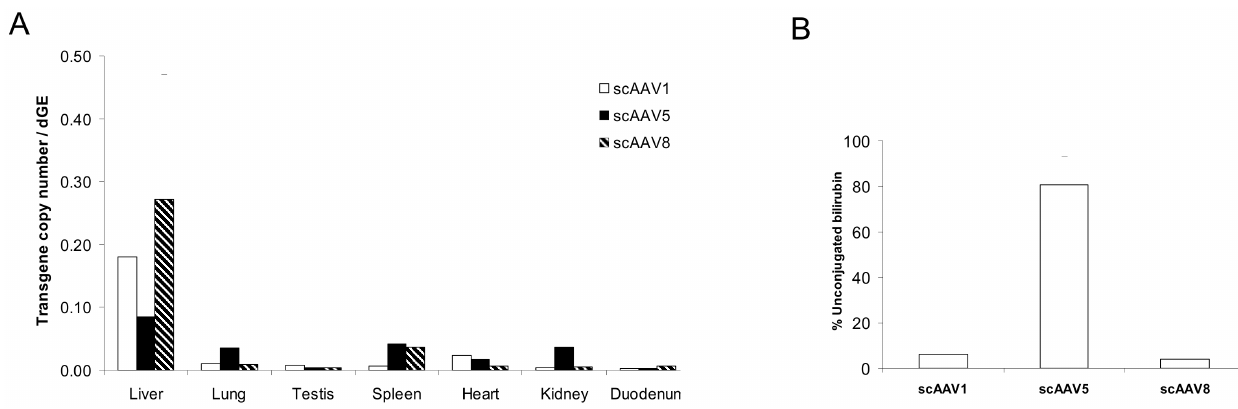
Figure 2. scAAV2/1, 5 and 8 vectors biodistribution and UGT1A1 mRNA expression levels in liver tissue. (A) UGT1A1 transgene copy number per diploid genome equivalent (dGE) in liver, lung, testis, spleen, heart, kidney and duodenum of male Gunn rats at 62 weeks after portal vein injection of scAAV1, 5 or 8 as calculated by the ratio of UGT1A1 copies and the rat b -actin gene copies in 100 ng of DNA as quantified by qPCR. (B) Relative UGT1A1 mRNA levels in liver quantified by qPCR and normalized with 18S rRNA levels. The results obtained with AAV5 are statistically significant different (p , 0.001) compared to the obtained with AAV1 and AAV8 using the nonparametric Mann–Whitney test. doi:10.1371/journal.pone.0082597.g002 primates this serotype had been shown to be effective this poor between two rat models and a mouse model was performed. This efficacy in rats was unexpected. To exclude a problem with the confirmed that the efficacy of AAV5 liver transduction is at least AAV5 vector and/or the rat model used a direct comparison 100 fold lower in rats. The poor efficacy cannot be explained by